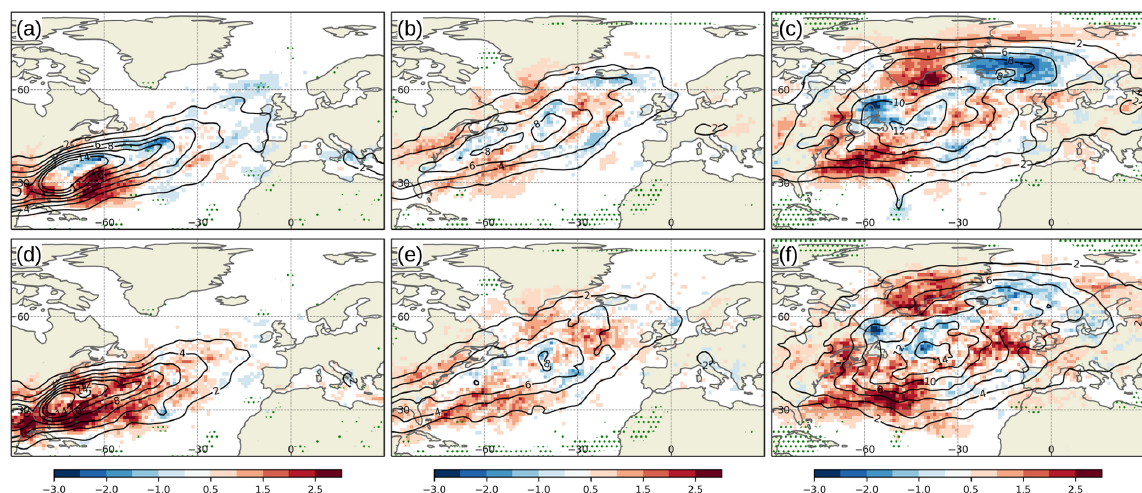
Figure 4. WCB frequency biases (shading in %) in ECMWF’s operational ensemble forecasts averaged over a forecast lead time of 126 to 144h as diagnosed with the (a, b, c) CNN-based approach and (d, e, f) with the trajectory-based approach. (a, d) WCB inflow, (b, e) WCB ascent, and (c, f) WCB outflow. Black contours denote the WCB frequency (%) in the period 1 December to 28 February in the three winters 2018–2019, 2019–2020, and 2020–2021 for the respective WCB stage. Areas where the biases identified with the two approaches are significantly different ( p value < 0 . 1) are highlighted by green